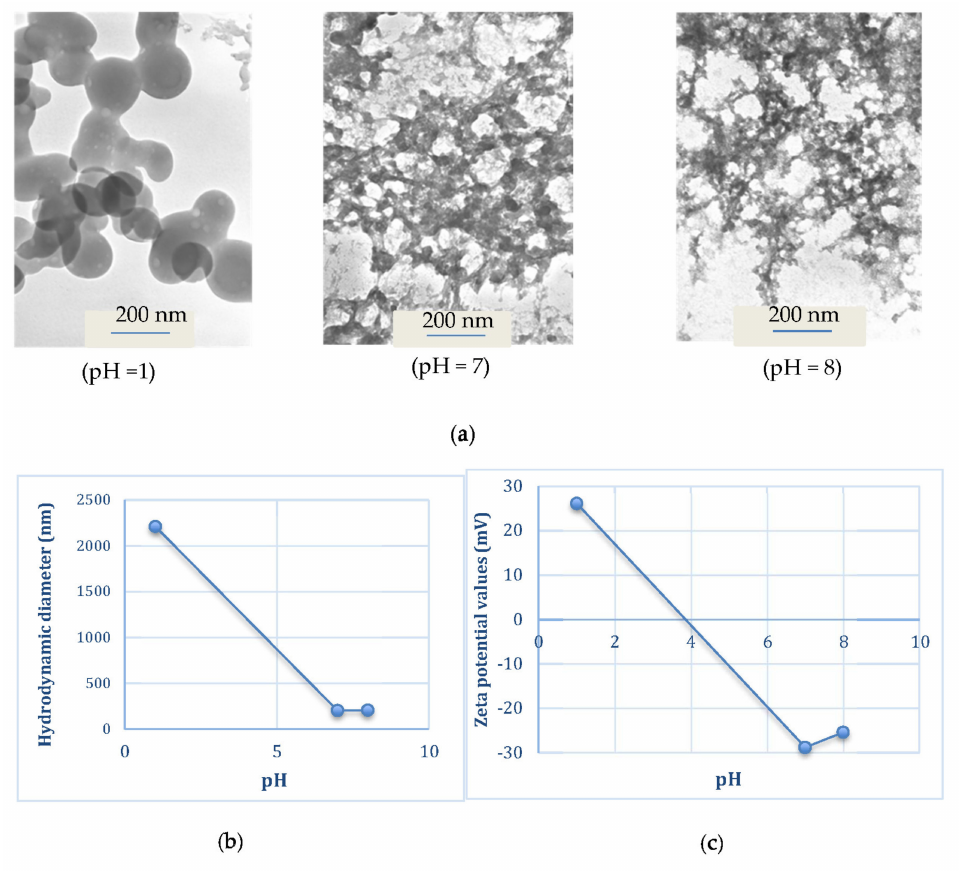
Figure 6. TEM micrographs ( a ), particle sizes ( b ) and zeta potentials ( c ) of 1 mg/mL blank NBSCh micelle in different pH